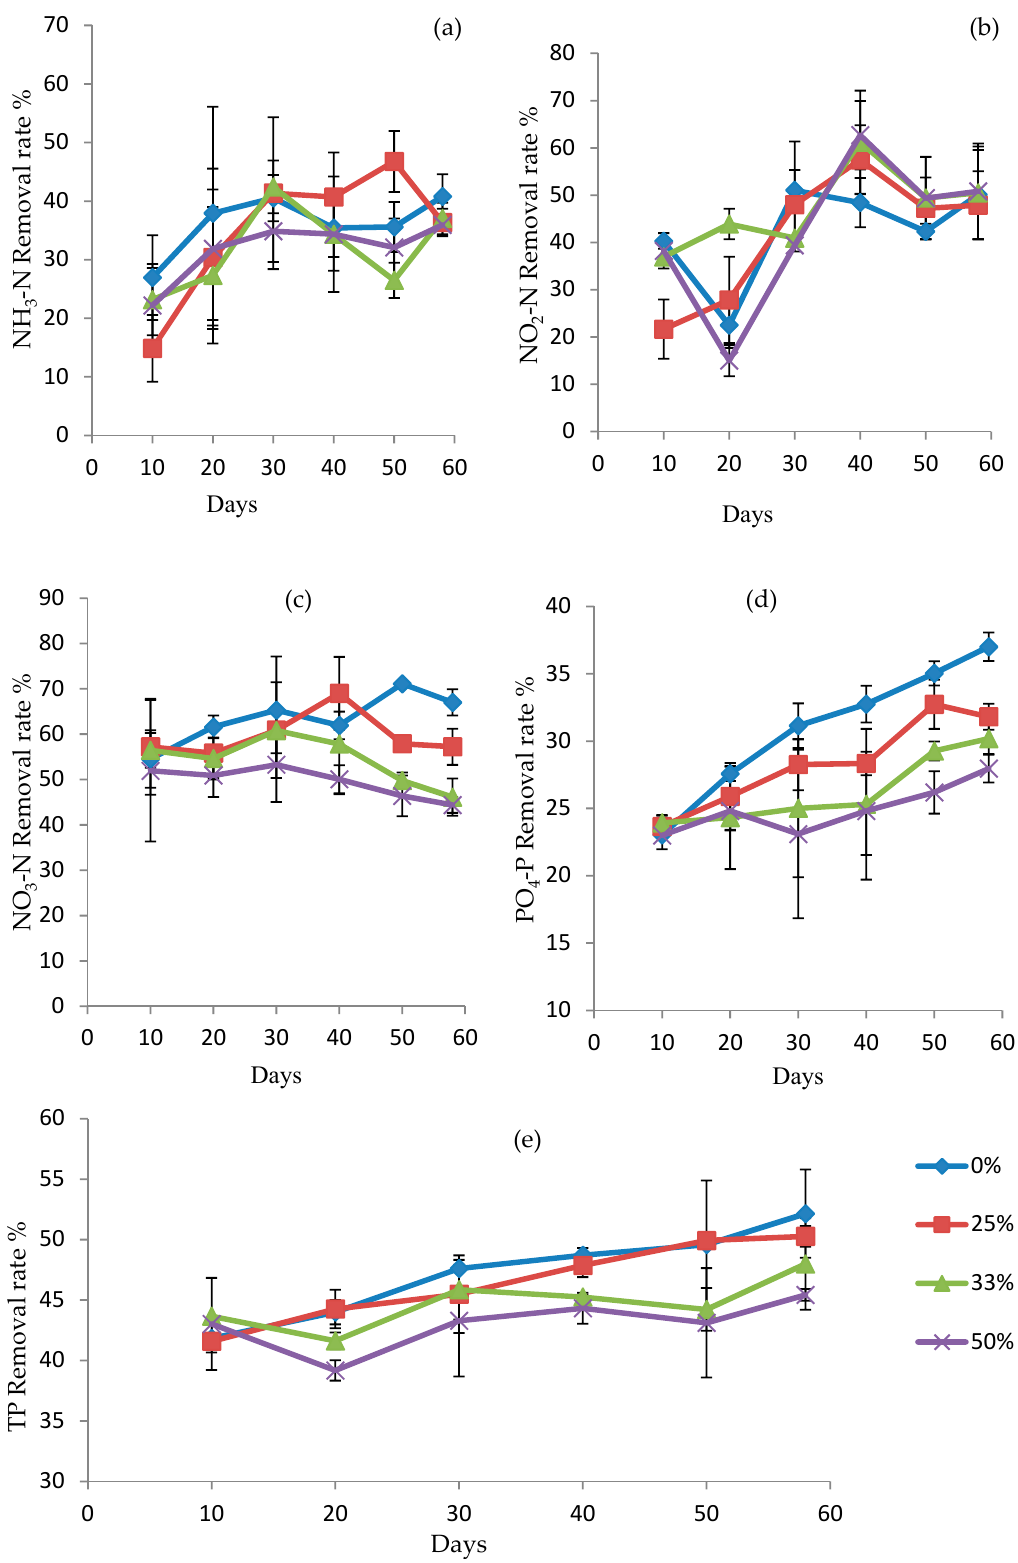
Figure 3. Removal rates for ( a ) ammonia nitrogen; ( b ) nitrite nitrogen; ( c ) nitrate nitrogen; ( d ) orthophosphate; and ( e ) total phosphorus in aquaponic systems under di ff erent plant harvesting regimes (data are the means of three replicates (n = 3), and error bars indicate the standard